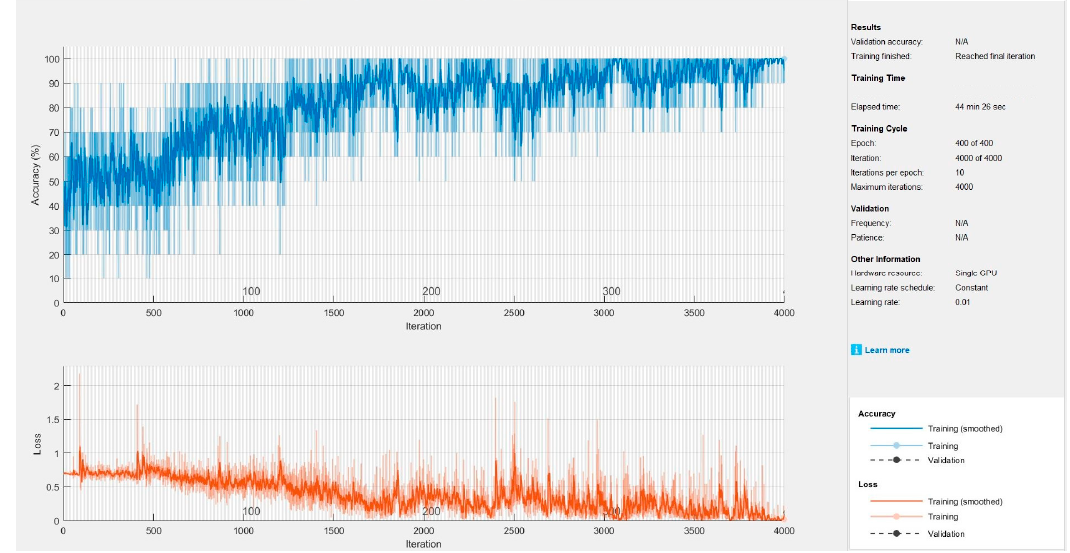
Figure 9. Training progress of proposed methods.